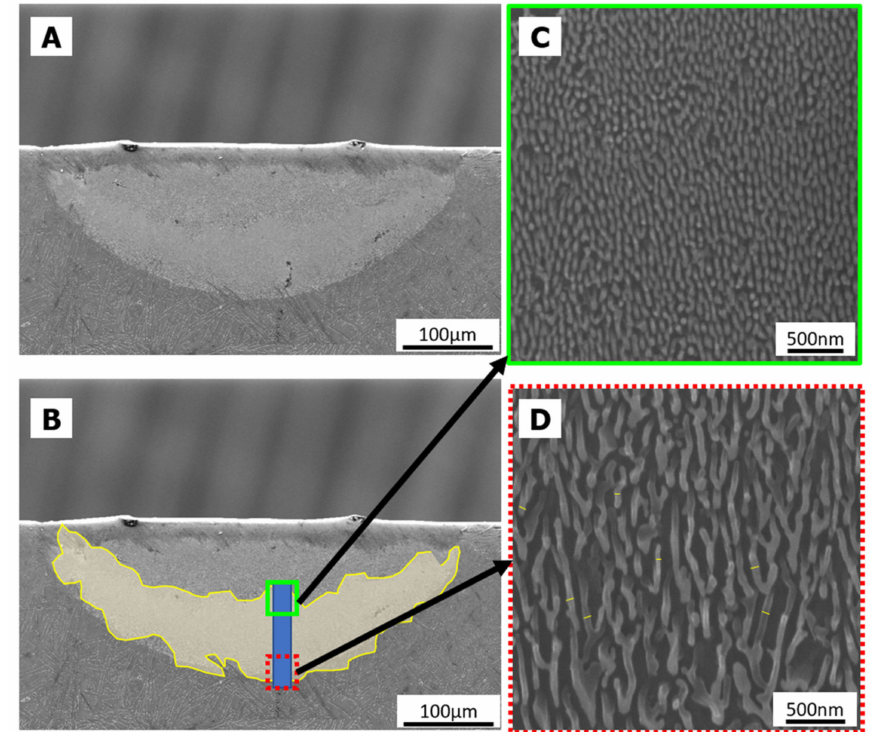
Figure 6. Regular eutectic formation and microstructure measurements at different depths. ( A ) Cross section of melt pool after LSR. ( B ) Same melt pool cross-section with highlighted yellow region denoting area of melt pool with fully eutectic microstructure. ( C , D ) are Si fibers from the top and the bottom of the eutectic area, respectively. Linear interception with cylindrical projection can be seen in the yellow bands in ( D ) (Al-20Si Exp#1). This figure shows how the total of 72 (18 × 3 original and 6 × 3 replications) experiments were